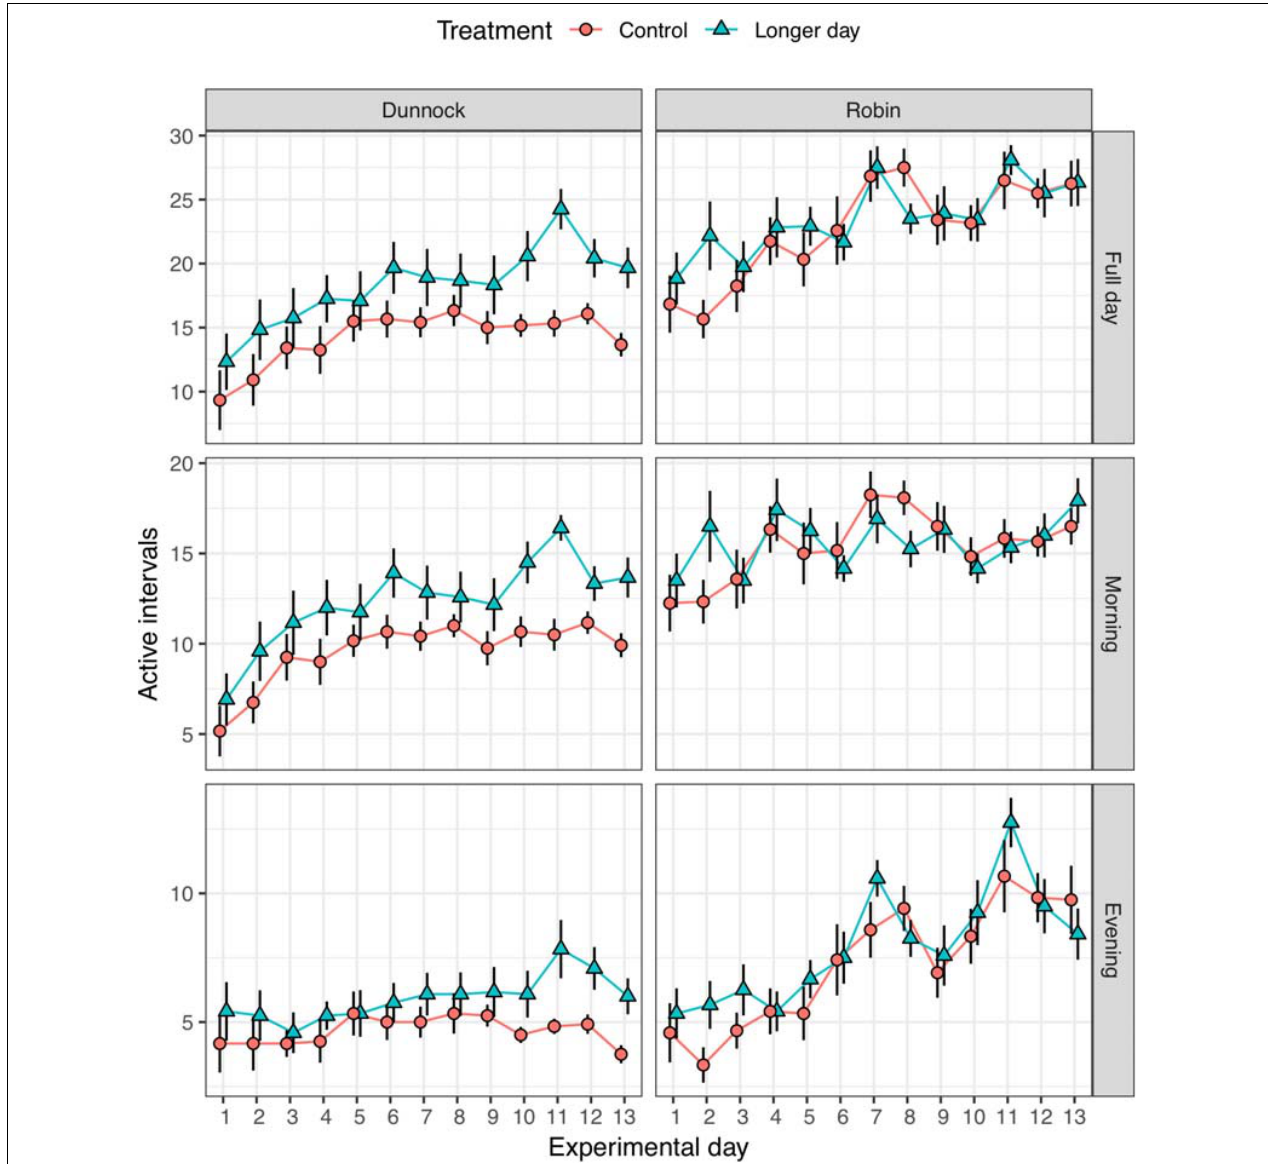
FIGURE 2 | Average ( ± SE) daily activity of first-year migratory dunnocks ( Prunella modularis ) and European robins ( Erithacus rubecula ) monitored under local daylength timing (Control) and early sunrise (Longer day) conditions ( n = 12 for each treatment group; n = 24 for each species). The daily activity was measured as the average number of 20-min active intervals (i.e., intervals when birds were flying for more than 1 min) presented for the full day, and divided in morning and evening